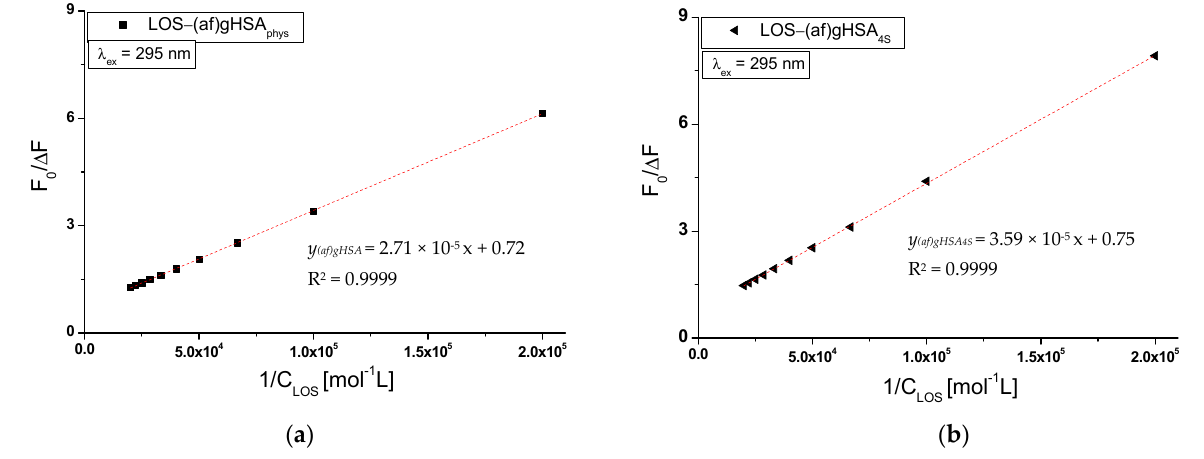
Figure 5. The Stern–Volmer curves modified by Lehrer for ( a ) LOS-(af)gHSA phys and ( b ) LOS- (af)gHSA 4S system; λ ex = 295 nm; the error bars are smaller than the symbols. The Stern–Volmer constant is used to assess the availability of the quencher to the excited fluorophore. The growth of K SV value is associated with the increase of ligand molecule availability to the macromolecule and the formation of the complex in an excited state. As can be seen in the Table 2, the higher values of K SV constant obtained for the LOS- (af)gHSA phys system compared to K SV obtained for LOS-(af)gHSA indicate the location of losartan molecules closer to the fluorophores of glycated, fatted by fatty acids physiolog- ical mixture albumin ((af)gHSA phys ) than glycated, defatted albumin (af)gHSA fluoro- phores.